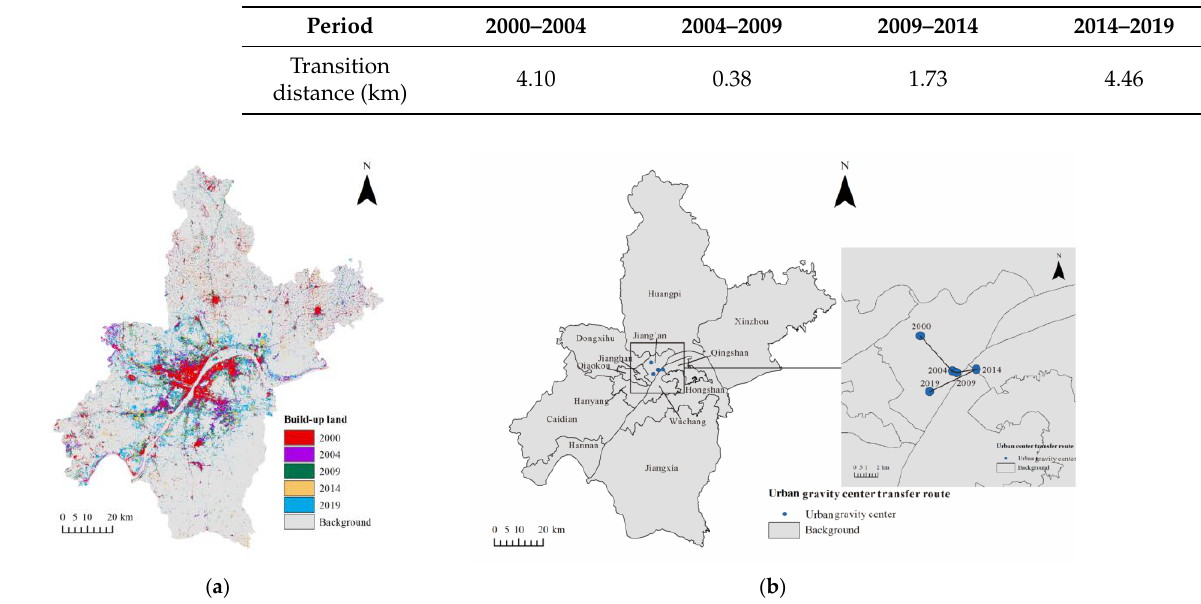
Table 6. Urban gravity center transition distance during different periods.